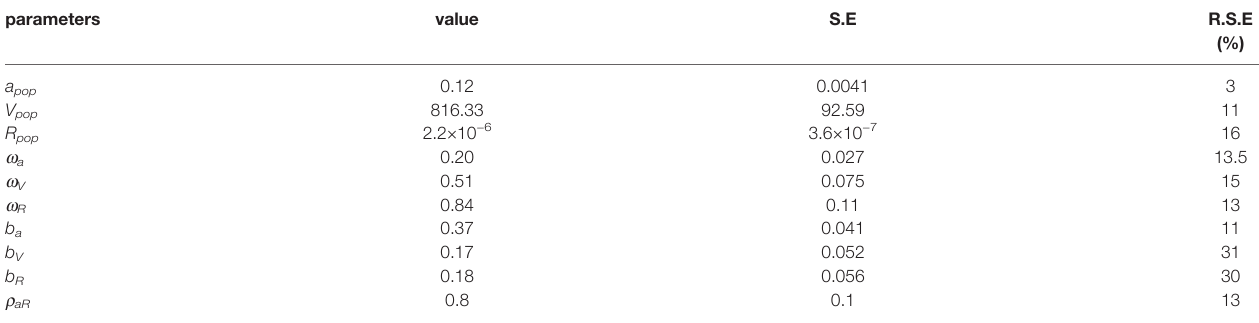
TABLE 2 | Estimated value of the parameters with their Standard Error (S.E.) and Relative Standard Error (R.S.E). parameters value S.E R.S.E